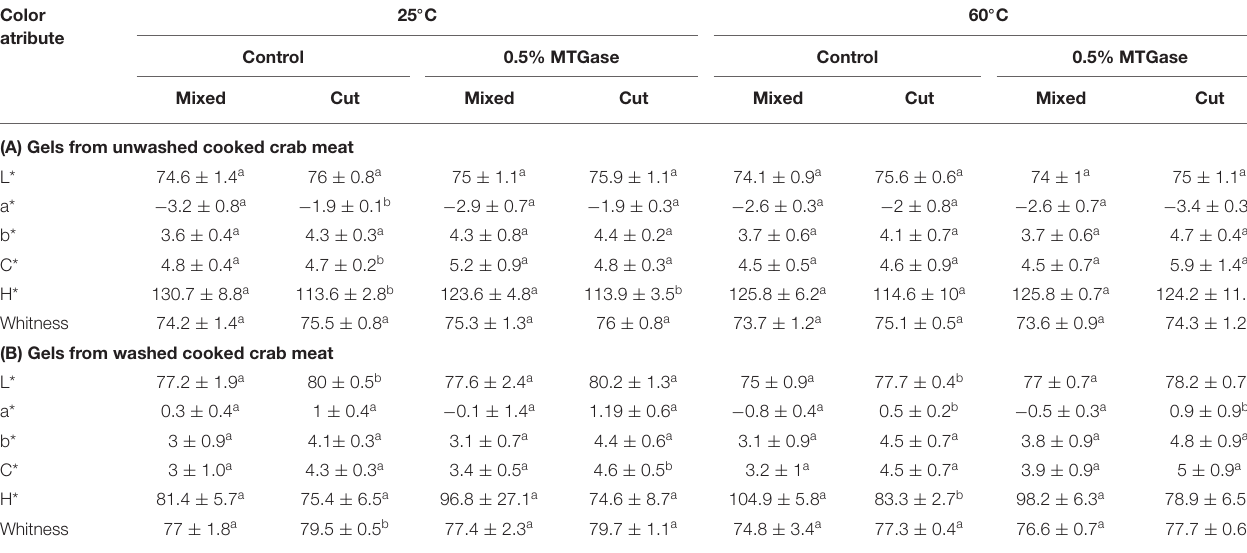
TABLE 1 | Changes in color attributes of gels by the effect of the type and temperature mixing method, washing of the cooked meat and adding of microbial TGase. Color